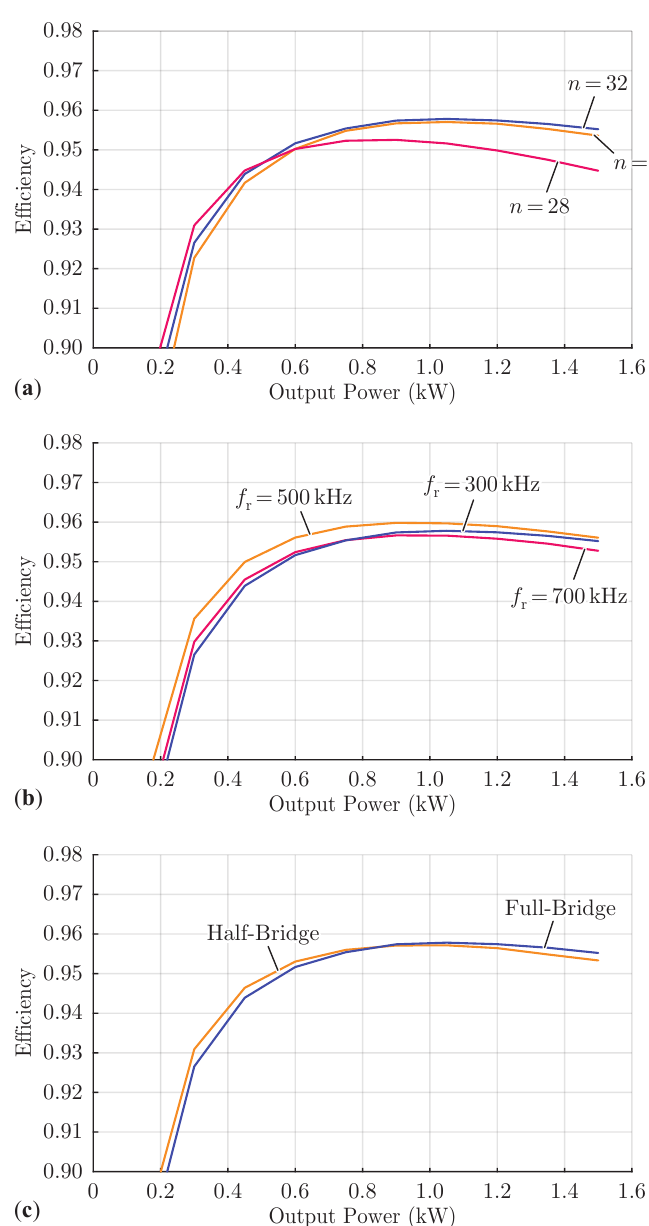
Figure 16. Calculated efficiencies at v dc = 400V and V o = 12V, highlighting optimal choices for ( a ) turns ratio ( n = 32) and ( b ) resonant frequency ( f r = 500kHz). Due to the non-ideal synchronous rectification, body-diode conduction losses increase at higher frequencies (practical behavior not captured by the loss models), which actually makes f r = 300kHz the best choice to maximize efficiency. ( c ) A HV half-bridge switching-stage (that prevents DCM operation) does not improve efficiency over the full-bridge, even though n is cut by